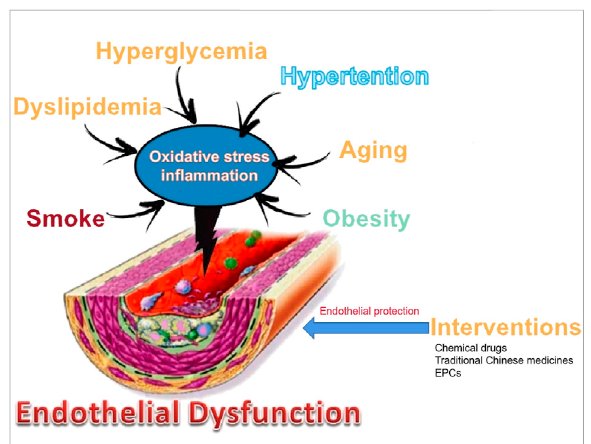
FIGURE 1 Mainvascularriskfactorsandtheirinvolvementinendothelial dysfunction and